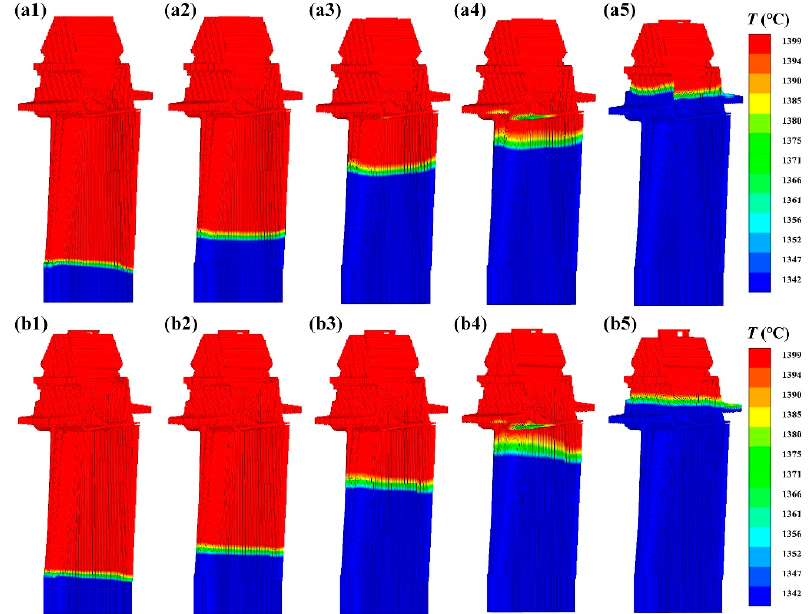
Figure 6. The mushy zone evolution with constant ( a1 – a5 ) and varying withdrawal rate ( b1 – b5 ) that are applied to the industrial gas turbine blade during the LMC process. The fraction solid in each figure is: ( a1 , b1 ) f s = 9%; ( a2 , b2 ) f s = 13%; ( a3 , b3 ) f s = 24%; ( a4 , b4 ) f s = 31%; and ( a5 , b5 ) f s = 67%.